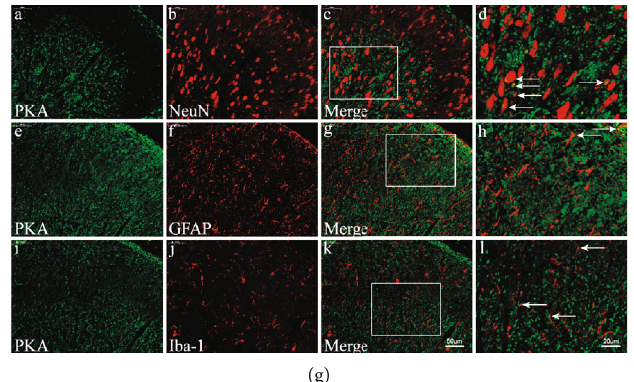
Figure 5: SNI causes neuropathic pain and increases the expression of PKA and p-p38 in the spinal cord. (a, b) SNI ipsilateral PWT (a) and contralateral PWT (b) ( n = 9 ). ∗∗∗ P < 0 : 001 versus Sham group. (c – e) Western blots and quanti fi cation of PKA and p-p38 expression in the spinal cord ( n = 3 ). ∗ P < 0 : 05 , ∗∗ P < 0 : 01 , ∗∗∗ P < 0 : 001 versus Sham group. (f) Immuno fl uorescence images showing PKA expression (green) in the dorsal horn of the spinal cord. (g) Immuno fl uorescence images showing the distribution of PKA in the cells of the dorsal horn of the spinal cord. PKA is green, NeuN, GFAP, and Iba-1 are